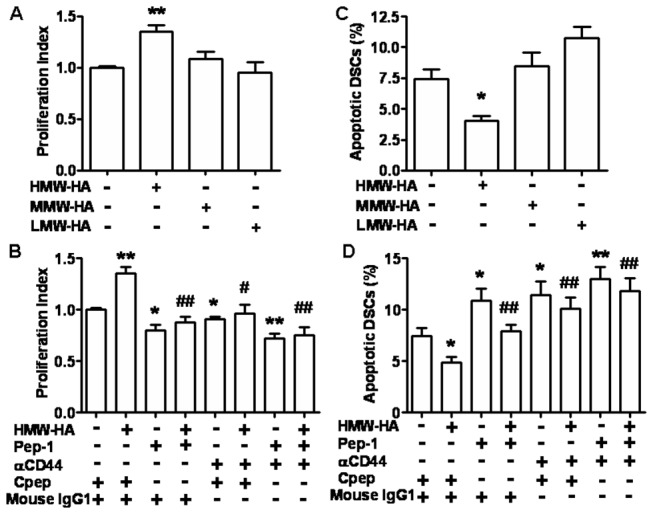
HMW-HA promotes growth of DSCs via binding to CD44.The primary DSCs in 96-well plates or 24-well plates were treated with different sizes of HA for 48 h. BrdU assay (A, B) and flow cytometry (C, D) were used to analyze DSC proliferation and apoptosis, respectively. The proliferation index of DSC cells under different conditions was normalized to the unstimulated control. Apoptotic cells were defined as AnnexinV + PI- DSCs. Control, isotype control IgG; HA, 100 µg/ml; α-CD44, anti-CD44 neutralizing antibody 20 µg/ml; Cpep, control HA peptide, 100 µg/ml; Pep-1, HA antagonist peptide, 100 µg/ml. Data represent the mean±SE of four separate experiments. *P<0.05, **P<0.01, compared to the control; #
P<0.05, # #
P<0.01, compared to HMW-HA treatment.